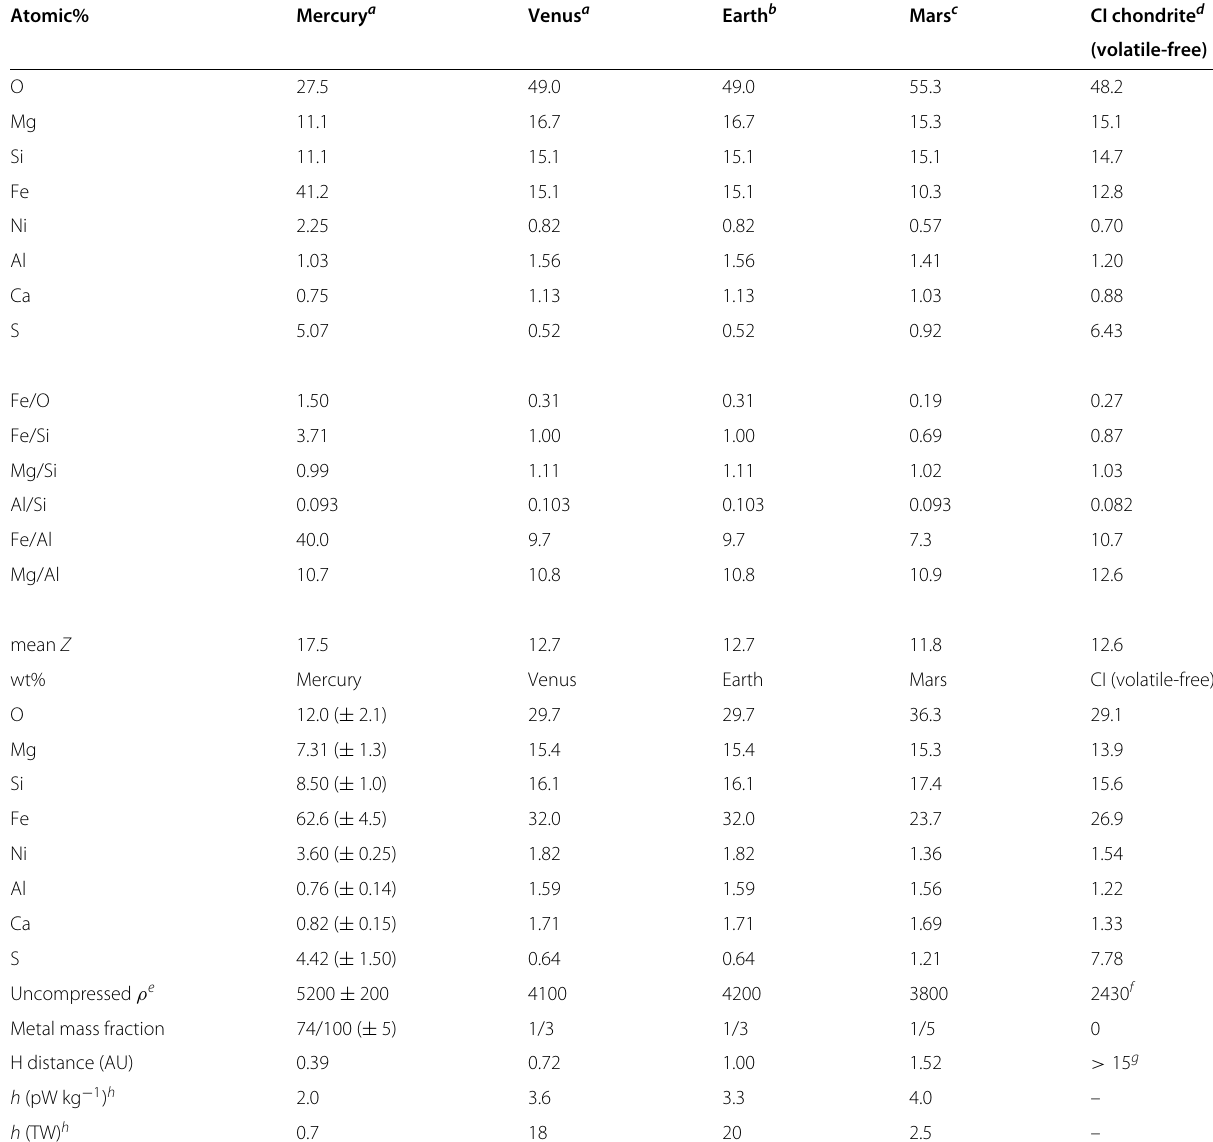
Table 1 Composition of the terrestrial